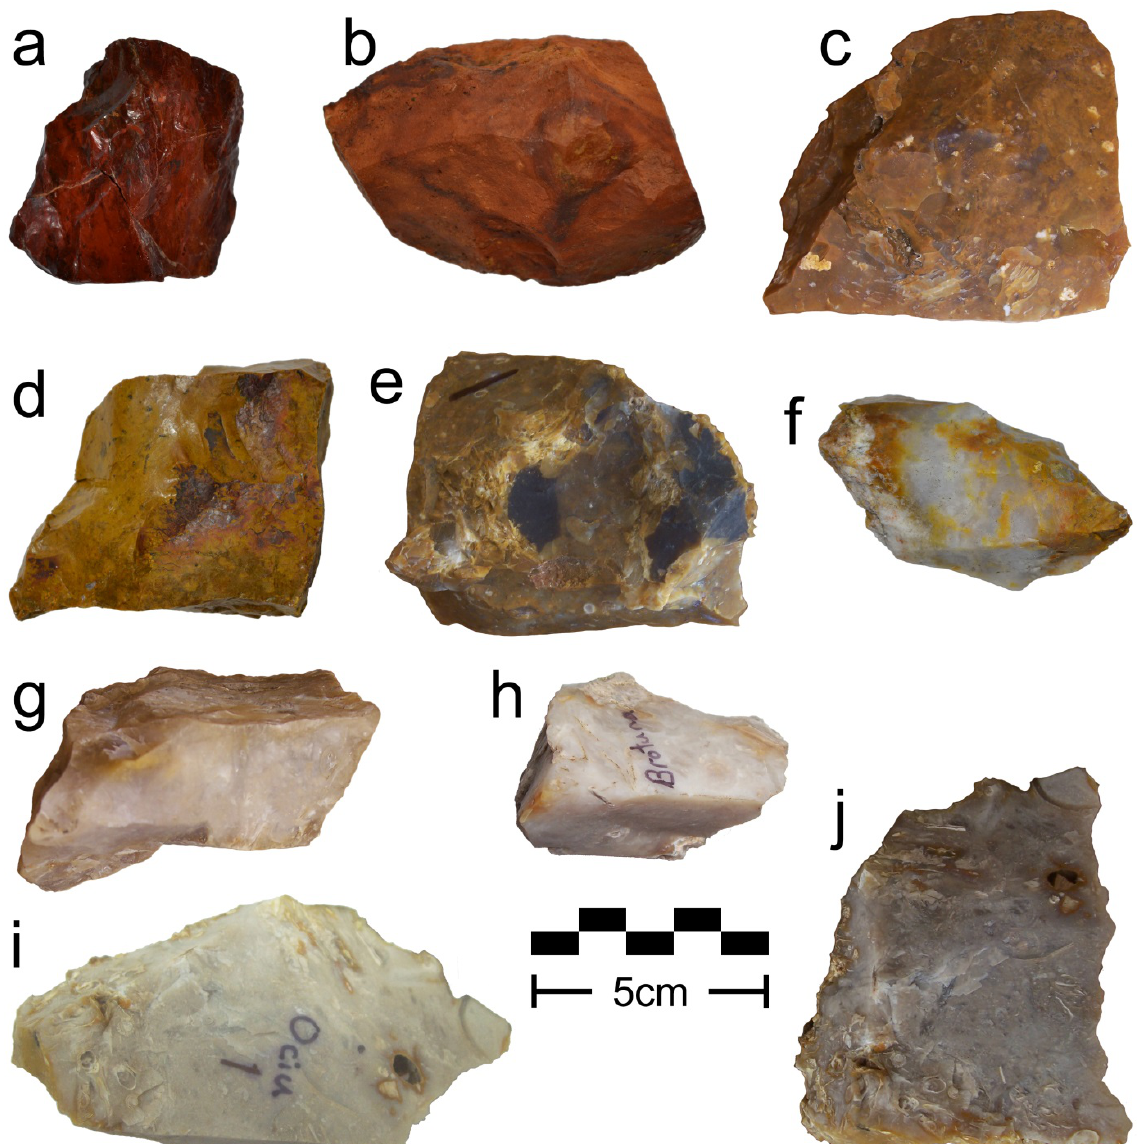
Figure 3. Photos of various colours of jasper from: a) to f) Măgura Hill (near the sanitorum), north-east of Brad; g) & f) Brotuna; i) & j)